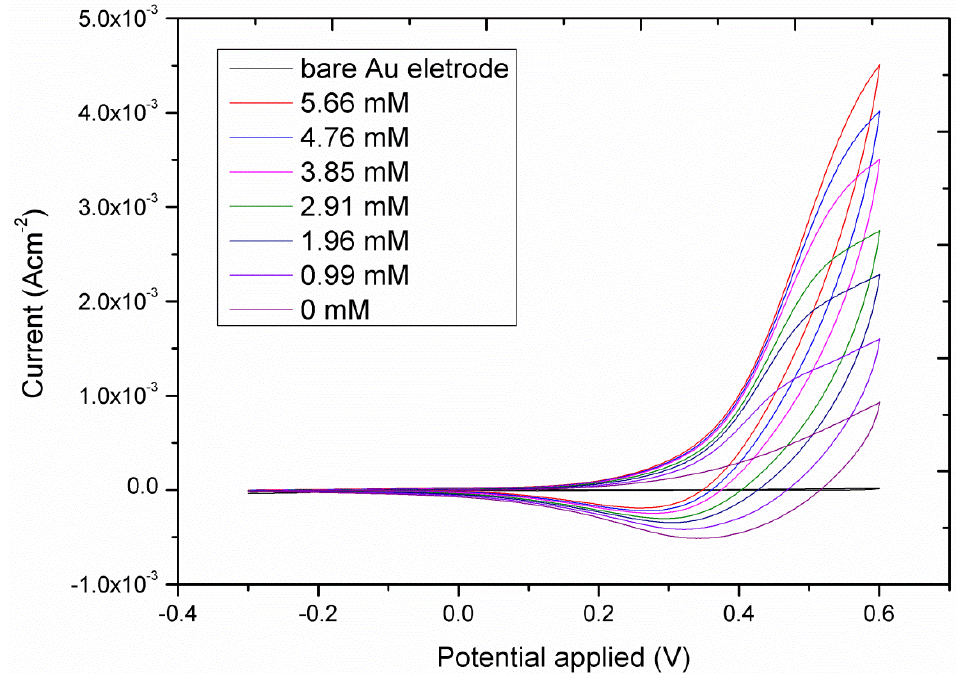
Figure 5. The CVs curve of CuO nanosheets based electrode in different concentrations of glucose at the scan rate of 10.00 mV/s.